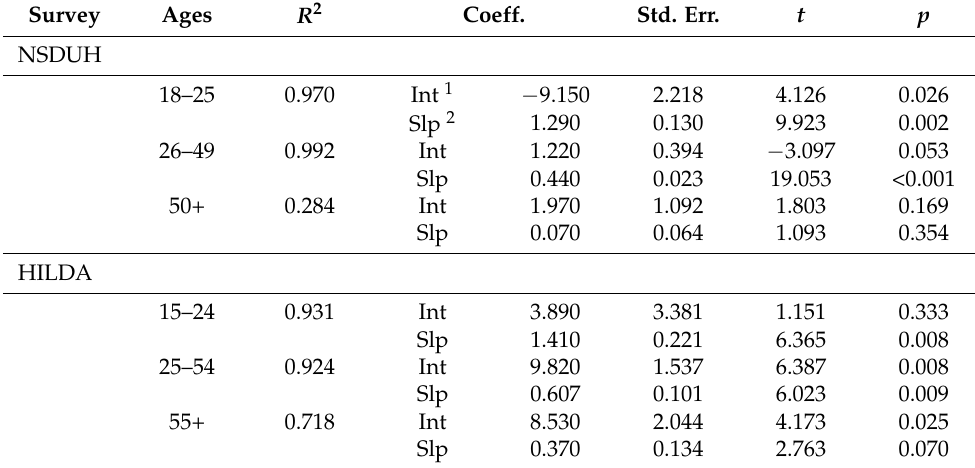
Table 1. Regression analyses (coefficients, standard errors, t , and p -values) of the last five waves of the National Survey of Drug Abuse and Health (NSDUH) and the Household Income Dynamics in Australia (HILDA) before 2020. Survey Ages R 2 Coeff. Std. Err. t